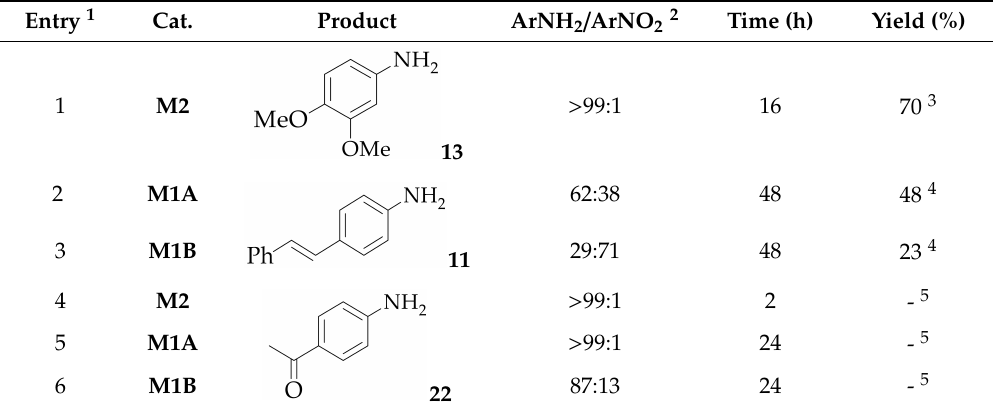
Table 10. Reduction of nitroarenes with hydrazine under catalysis by Rh